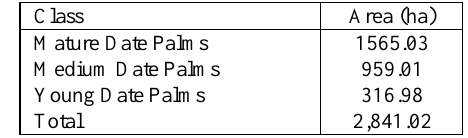
Table 3. Area per hectare of date palms in Eastern District, Abu Dhabi